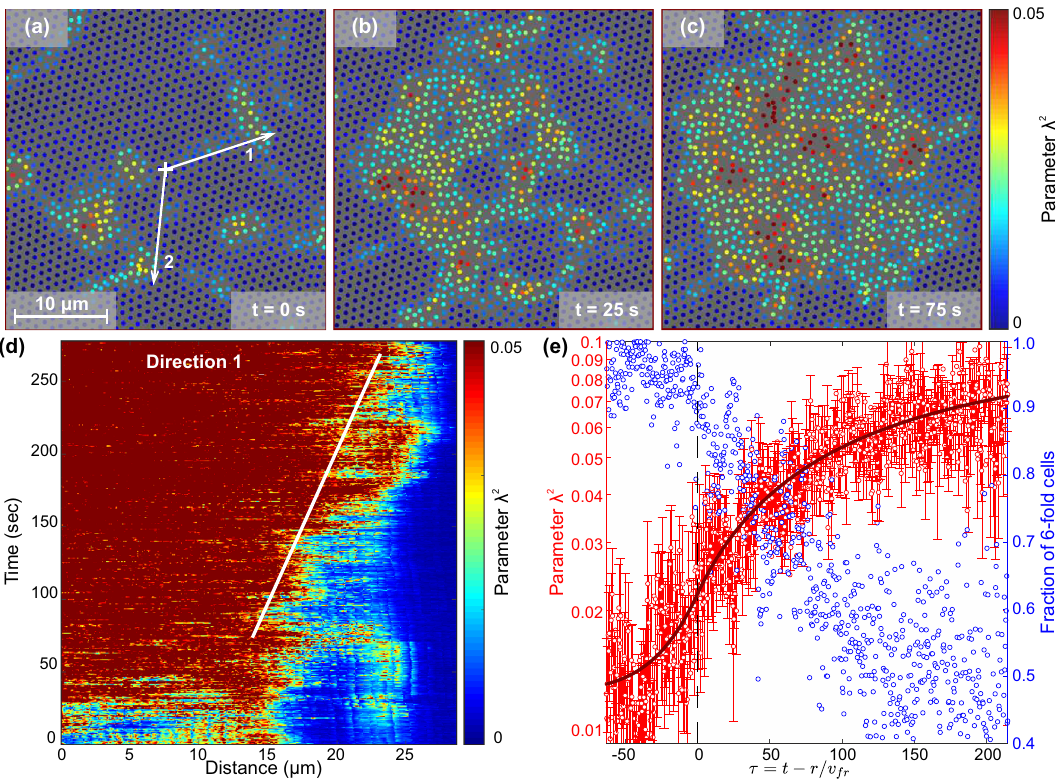
Figure 2. Experimental reveal of the self-similar (cid:31) 2 -profile in the propagating melting front in bulk colloidal crystal at intermediate superheating: ( a )–( c ) consequent snapshots of the system, where the symbols are particles coloured in accordance to the (cid:31) 2 -value (see Supplemental Movie 1). ( d ) Evolution of the field (cid:31) 2 ( r , t ) in the radial direction (1) shown in ( a ). ( e ) (cid:31) 2 (τ) -profile in the propagating melting front during the nuclei growth. The red symbols are experimental points, the red solid line is the theoretical fit (8). The blue symbols are the fraction of 6-fold Voronoi cells in the plane of analysis, with the sudden drop indicating the structure is